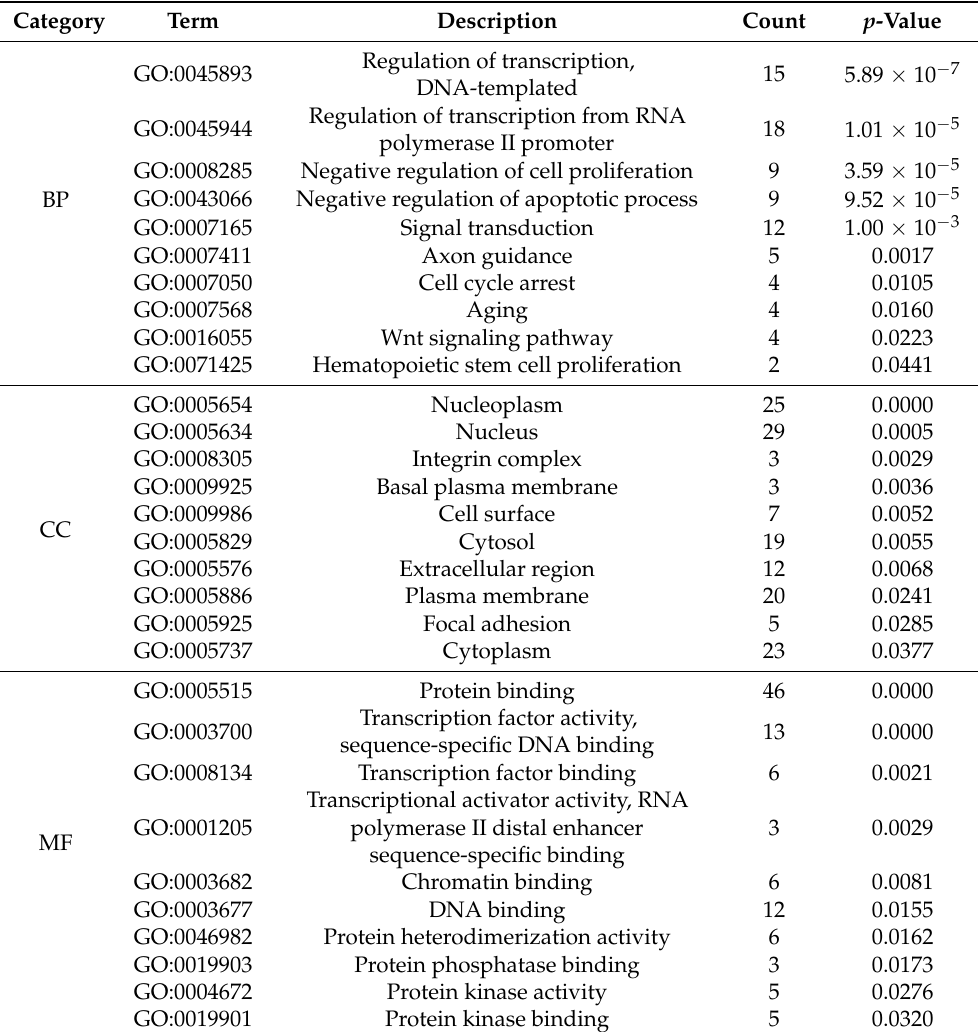
Table 1. GO analysis of DEC resistance-related